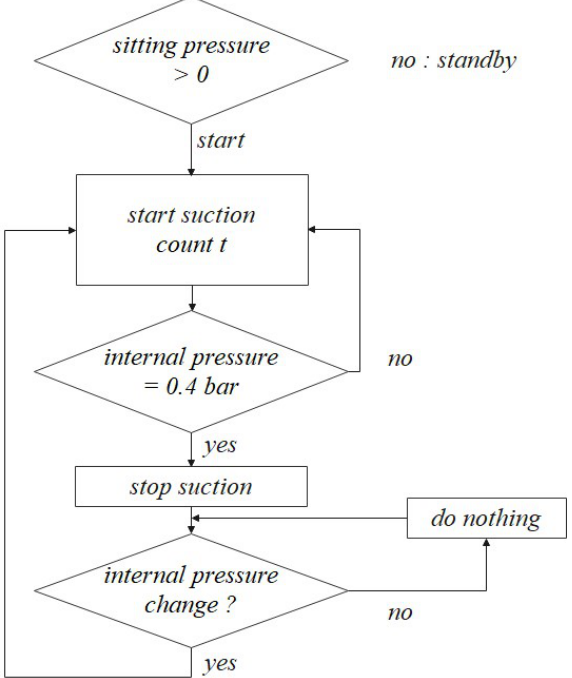
Figure 6. Actuation process chart of SSA